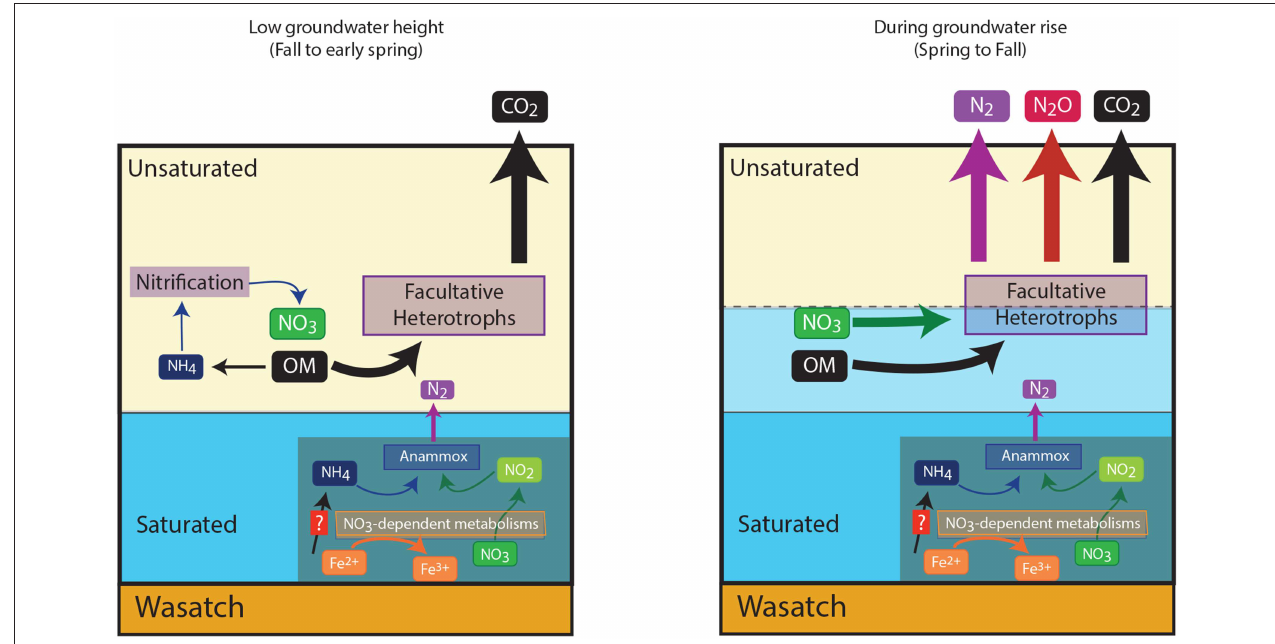
FIGURE 5 | Conceptual nitrogen cycle within the Rifle aquifer based on measurements made in the present study, and recent molecular based studies. The figure shows the switch in metabolic processes at the capillary fringe, and also the likely positioning of anaerobic chemolithoautotrophs in the naturally reduced zones of the aquifer. This aquifer is underlain by an impermeable Wasatch layer indicated in the